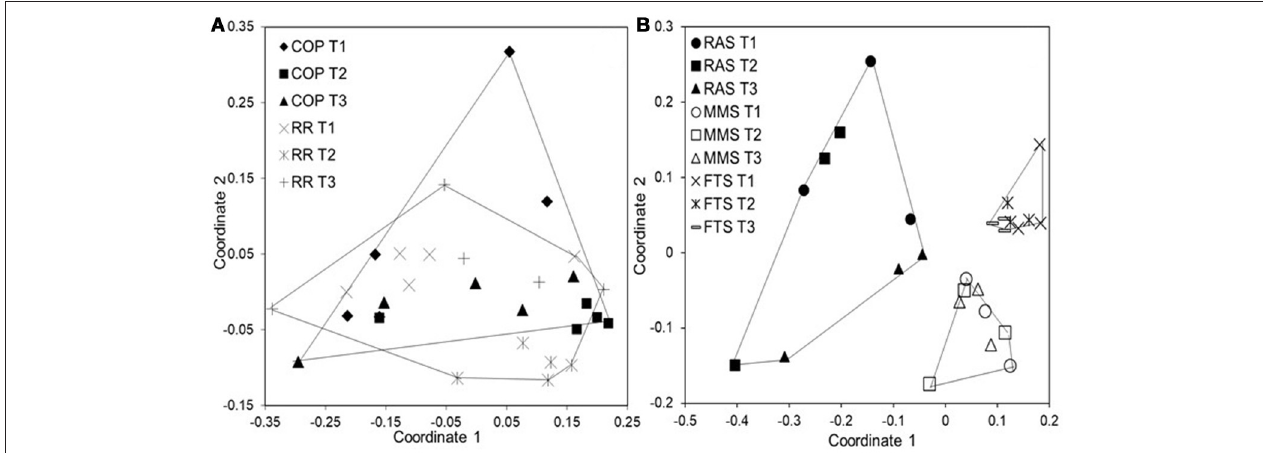
FIGURE 6 | Non-metric MDS plots based on Bray-Curtis similarities for cod larval microbiota at 17 dph. (A) Microbiota from 30 larvae representing the diets COP (Copepods fed algae) and RR (rotifers fed algae); 5 individuals from each replicate rearing tank (based on data from Bakke et al., 2013). (B) Microbiota from 27 larvae representing the rearing water systems FTS, MMS, and RAS; 3 individuals from each replicate tank.